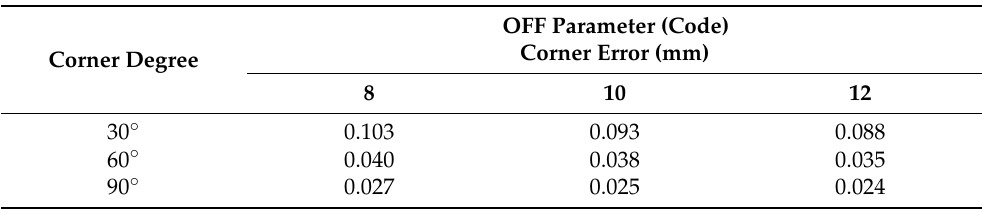
Table 7. Pulse-off time (OFF) vs. corner error.